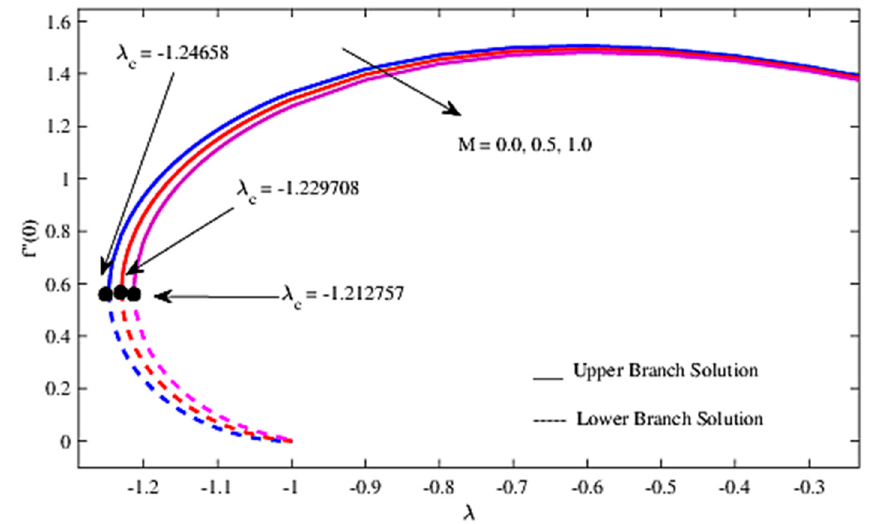
Figure 2. Variation of the skin friction coe ffi cient f (cid:48)(cid:48) ( 0 ) with λ for di ff erent values of M with ε = 1000, Q = 0.1 and Pr = 1.0.